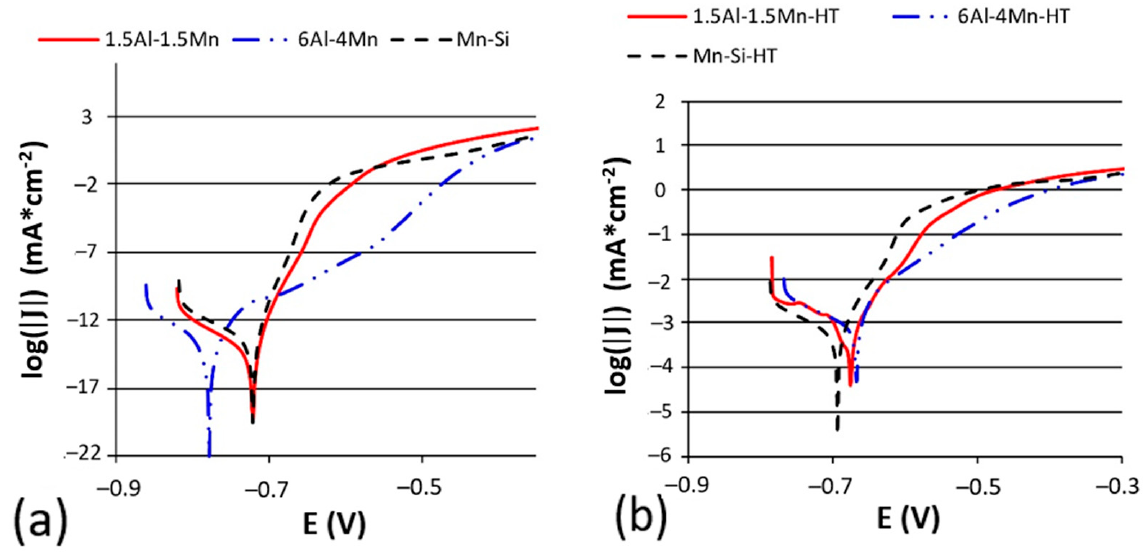
Figure 4. Polarization curves; ( a ) forged and annealed samples, ( b ) heat treated samples. The quantity of corrosion products (Figure 5) and corresponding weight loss after exposure testing (Figure 6) follow the trend of the three distinct steel types. The 6Al-4Mn steel exhibits only mild pitting corrosion (Figure 5b) and the average weight losses for both forged and annealed and heat treated samples are below 1 mg. The most significant corrosion damage developed on the Mn-Si steels (Figure